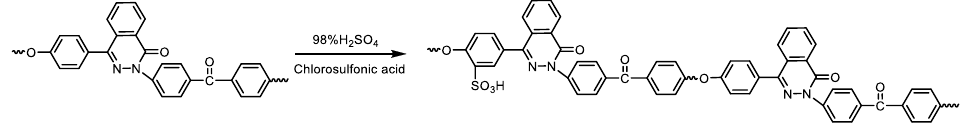
Figure 1. Reaction scheme for the synthesis of SPPEK.